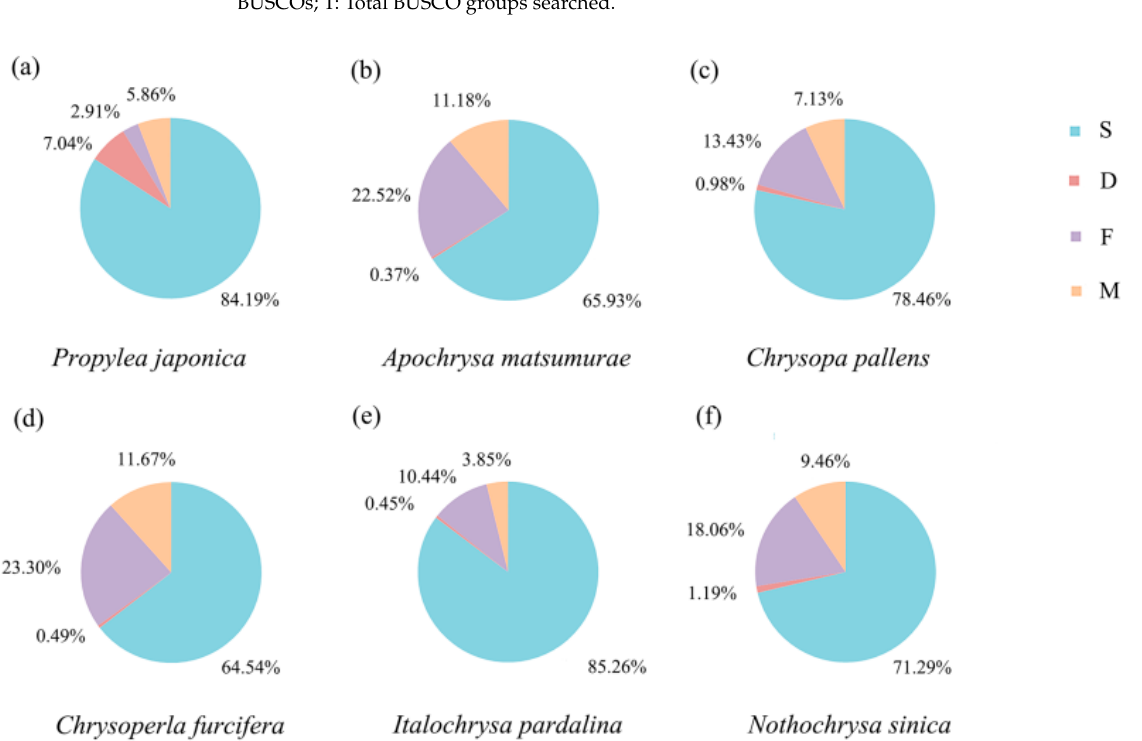
Figure 1. Characteristics of newly sequenced genomes in this study inferred using GenomeScope. len: genome haploid length; uniq: percentage of the genome unique length; het: heterozygosity; kcov: coverage of hybrid peak; err: read error rate; dup: duplicates; k: k-mer size.